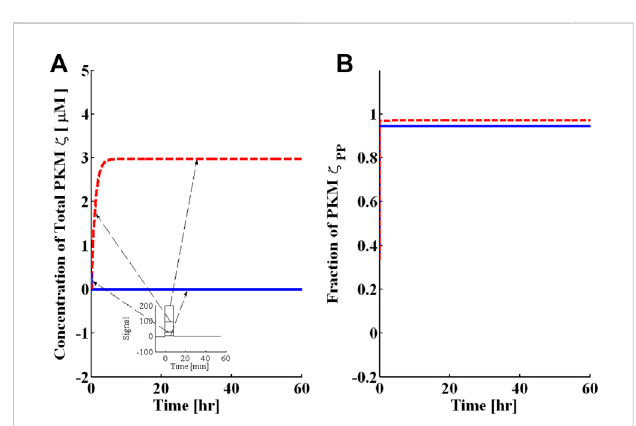
FIGURE 2 Bistability characteristics of the PKM ζ local translation loop. A brief pulse of protein synthesis is used to mimic the induction of L-LTP by applying a high-frequency stimulus. The solid blue line represents PKM ζ , the concentration at basal levels of protein synthesis (without the application of pulse), and the dashed red line represents the PKM ζ concentration with the application of a protein synthesis pulse. (A) Total PKM ζ concentration [ μ M] with the lower steady state at .0003 μ M and the upper steady state at ≈ 3.0 μ M. The inset mimics the HFS protocol representing the different strengths of protein synthesis pulse for L-LTP. (B) Fraction of doubly phosphorylated and active PKM ζ with the lower steady state at ≈ 94% and the upper steady state at ≈ 98%. These results show that even with different amplitudes of protein synthesis pulse stimulus, the PKM ζ loop converges to the same up or downregulated states. These results indicate that this system is bistable; that is, with a suf fi ciently strong stimulus, it becomes upregulated, and without enough stimulus, it is